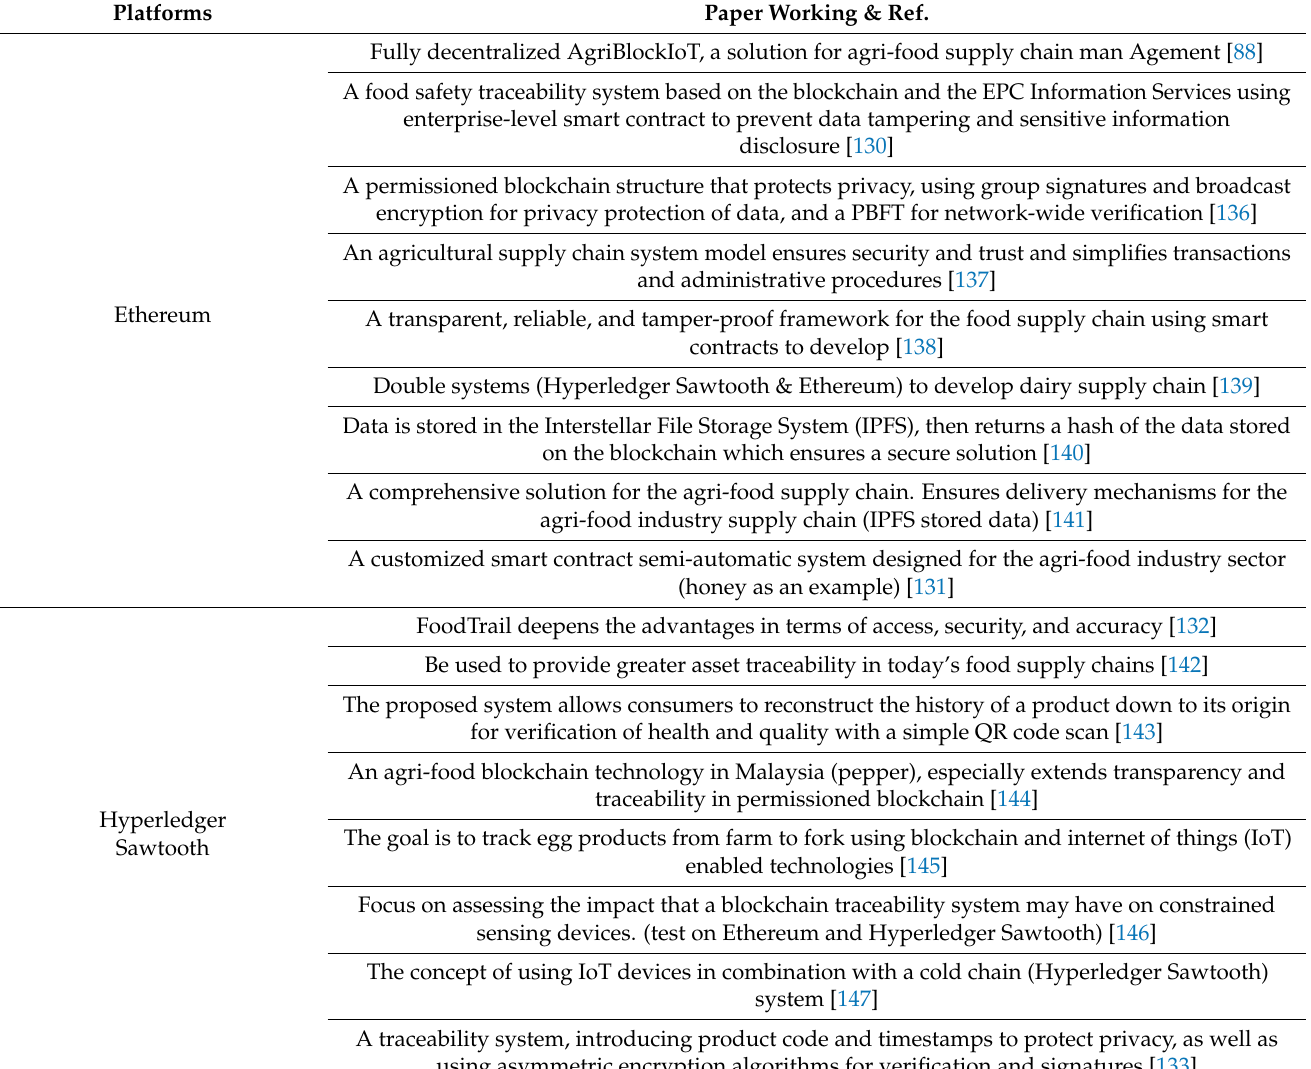
Table 7. Related food traceability platforms. Platforms Paper Working &